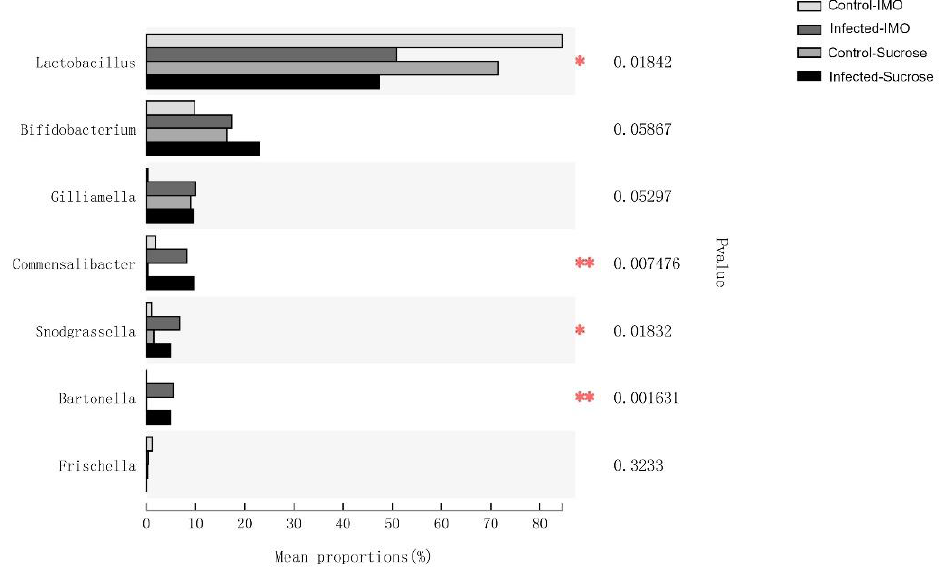
Figure 7. The differences in bacterial population ratios among the treatment groups. The multiple group comparisons were calculated using the Kruskal–Wallis test with the False Discovery Rate (FDR) approach and Welch’s posthoc method. The comparisons were made at the bacterial genus level. Significances ( p < 0.05) are labeled by asterisks, and highly significances ( p < 0.01) are labeled by double